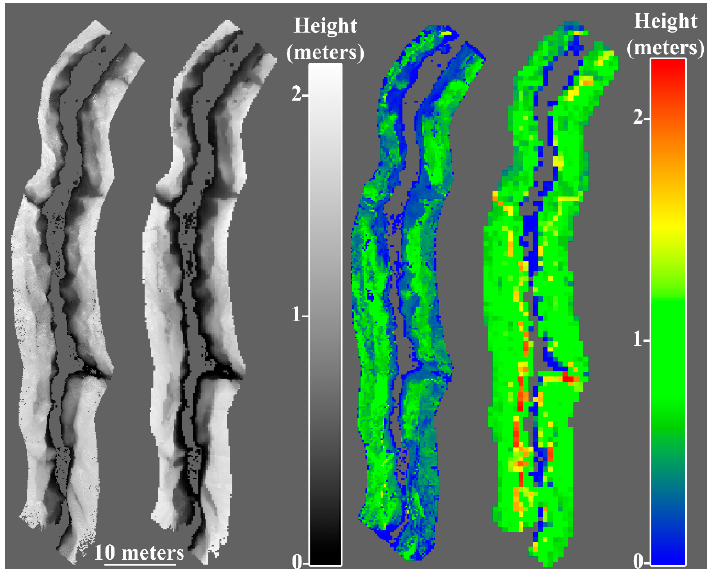
Figure 13 . Terrestrial lidar point cloud (far left), and representation of geomorphology (middle left, 0.25 m resolution) used a baseline for estimating Spartina alterniflora vegetation height from terrestrial (middle right, 0.25 m resolution) and airborne lidar (far right, 0.75 m resolution).